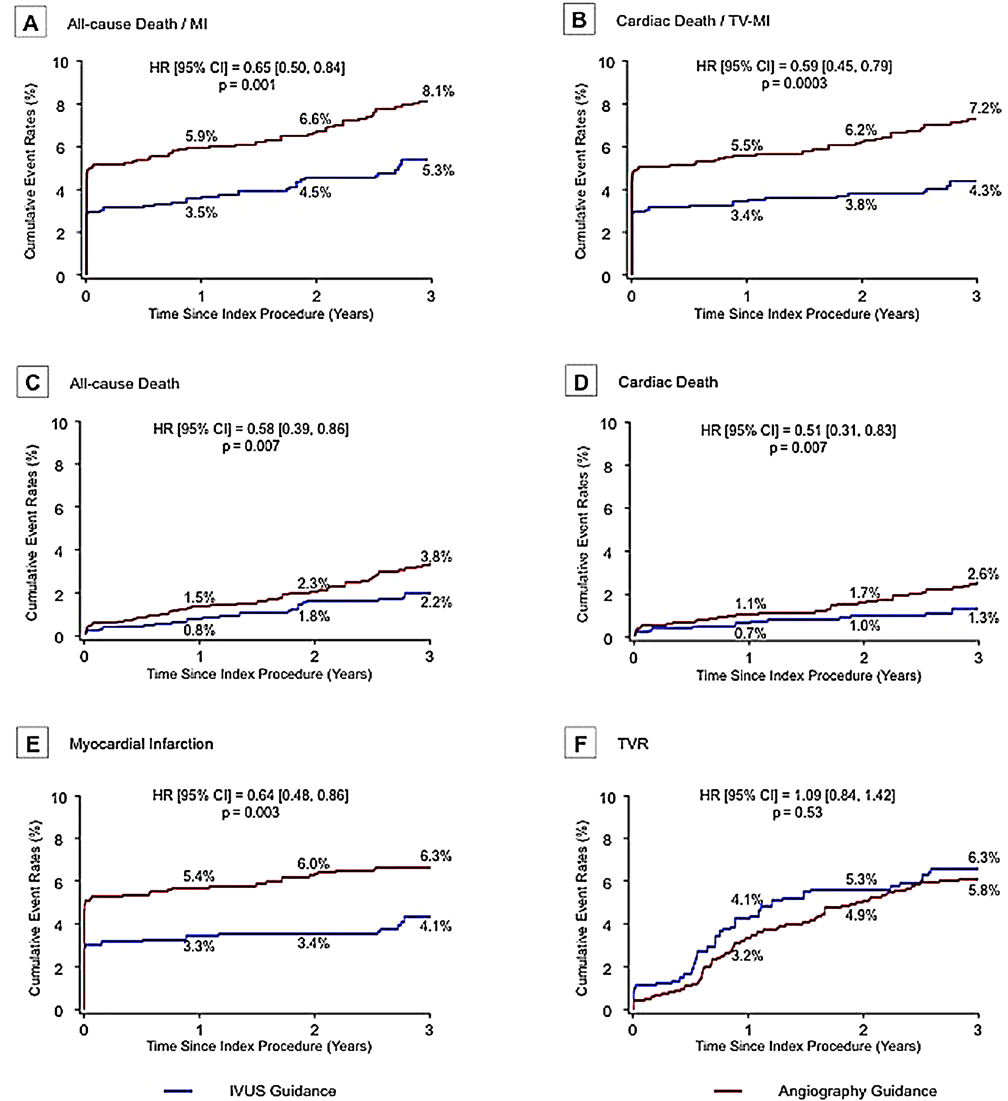
Figure 3. Adjusted Kaplan-Meier Curves of 3-year Outcomes. Trimmed inverse probability weighted Cox proportional-hazards regression was used with adjustment for all patient-level variables in Supplementary Table 1. The HRs were reported for patients with IVUS guided versus those without IVUS guided. Abbreviations as in Figs 1 and